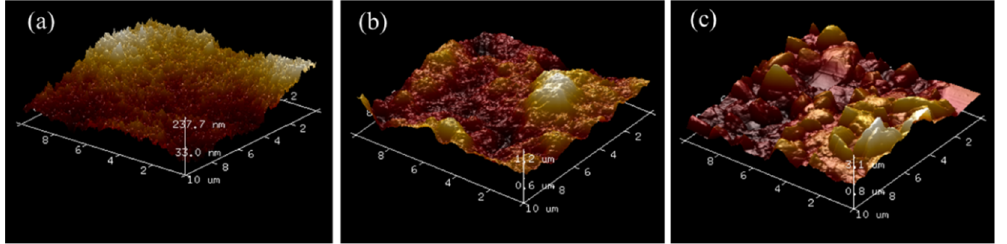
Figure 5. AFM diagrams of ( a ) pure MXene, ( b ) MXene/attapulgite composite (1:2), and ( c ) MXene/attapulgite composite (1:4).